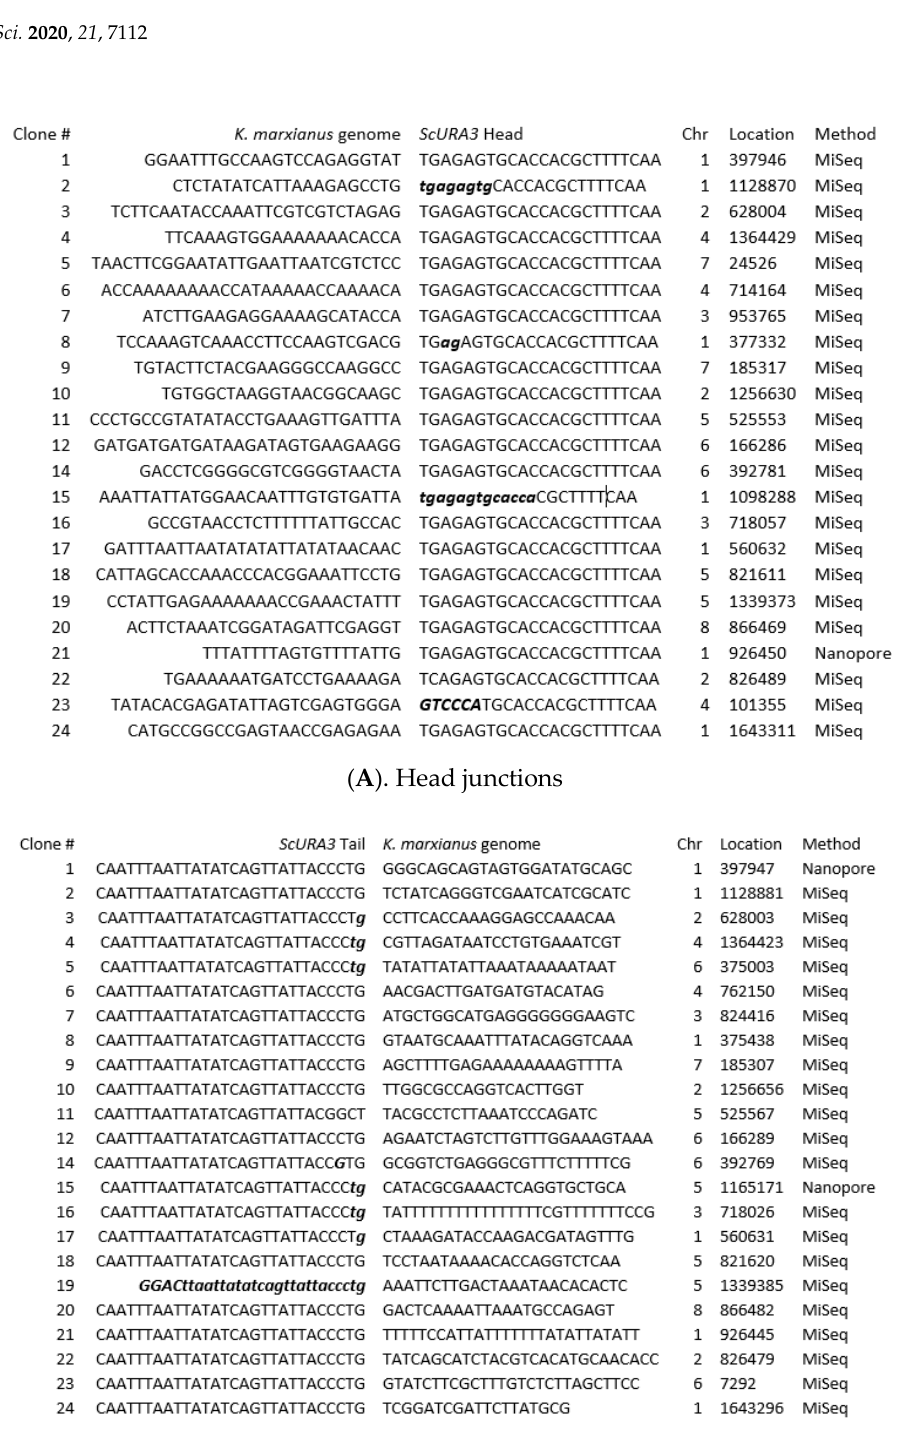
3 of 10 Figure 1. Construction of ScURA3 head (arrow, labeled H) and tail (labeled T) junction libraries. DNA